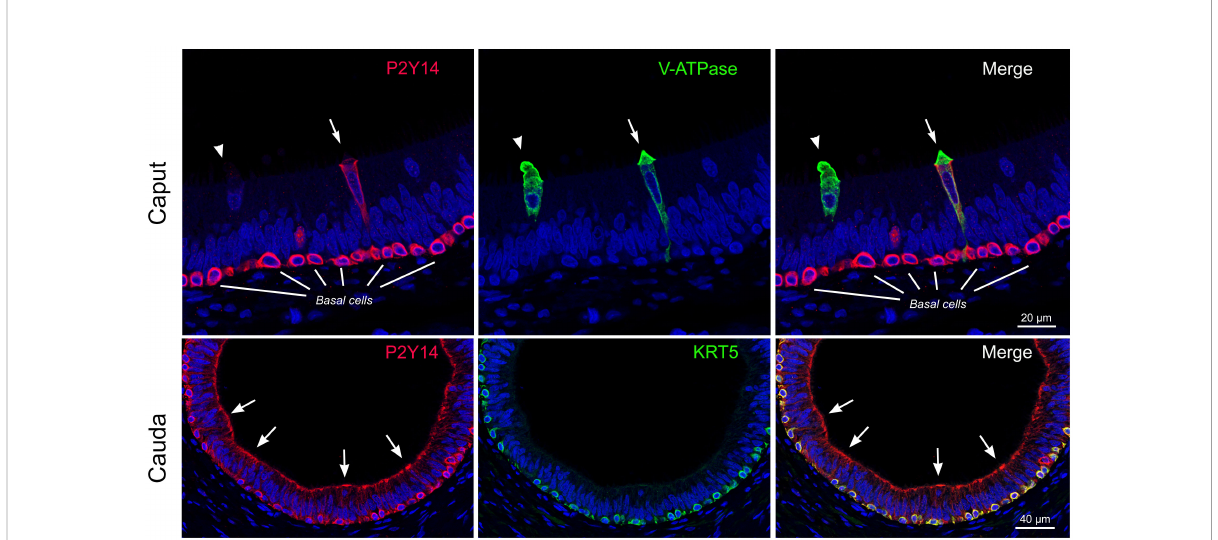
FIGURE 5 Localization of the pro-in fl ammatory P2Y14 receptor in the human epididymis. Top panels: Double immuno fl uorescence labeling for P2Y14 (red) and the B1 subunit of the V-ATPase (V-ATPase: green) in the human caput epididymis. Two V-ATPase-positive clear cells are shown (arrow and arrowhead). Only one clear cell is labeled for P2Y14 (arrow). Basal cells show strong labeling for P2Y14. Scale bar = 20 µm. Bottom panels: Double immuno fl uorescence labeling for P2Y14 (red) and cytokeratin 5 (KRT5: green) in the human cauda epididymis. Principal cells show strong apical labeling for P2Y14 (arrows). P2Y14 is also detected in KRT5-positive basal cells. Scale bar = 40 µm. Modi fi ed from Belardin et al. Andrology